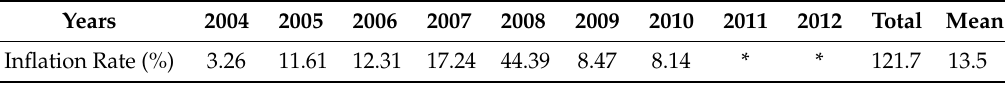
Table 5. The trend of Ethiopia’s annual inflation rate consumer prices